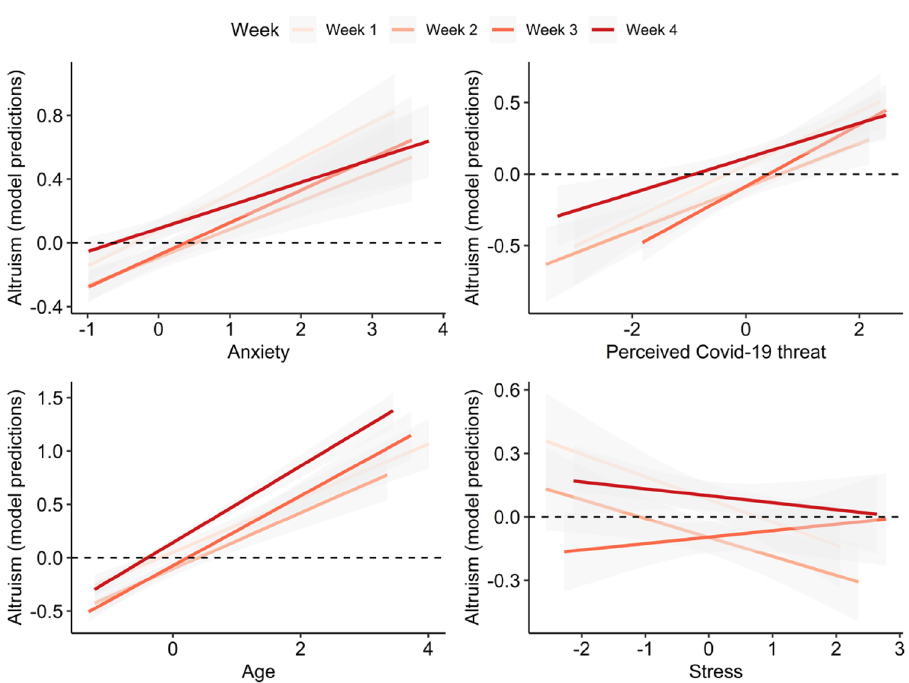
Figure 3. Model 2 predictions of everyday altruism (SRA) as a function of Anxiety (top left), Perceived COVID-19 threat (top right), Age (bottom left) and Stress (bottom right), depicting estimated random slopes per week.